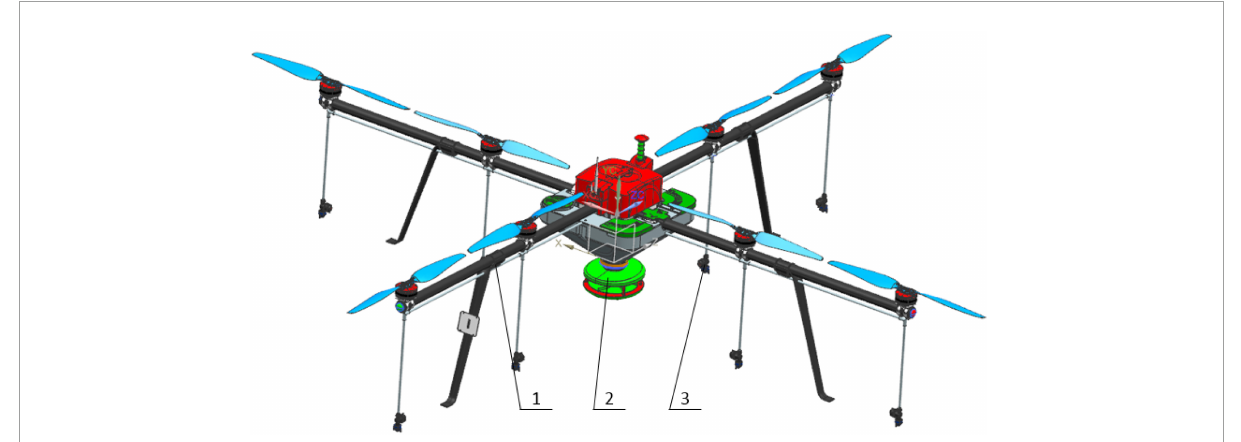
FIGURE2 3D overall design of mUAV. 1 represents the public flight control platform, 2 represents the device for spreading seed or fertilizer, and 3 represents the entire system used for pesticide